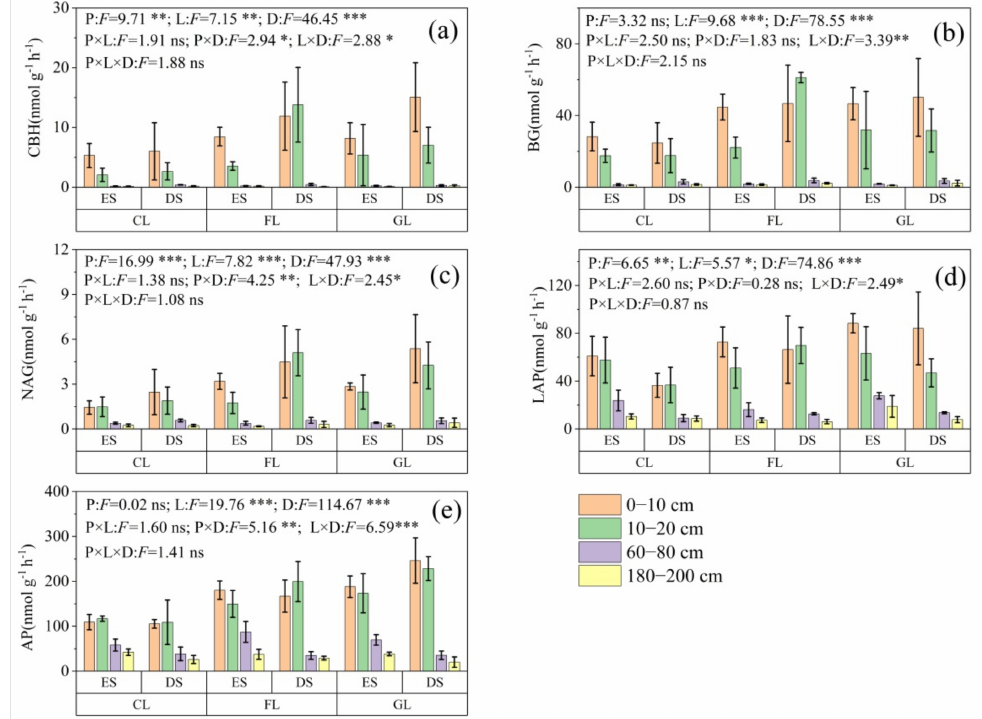
Figure 2. Soil microbial enzymatic activity of ( a ) CBH, ( b ) BG, ( c ) NAG, ( d ) LAP, and ( e ) AP from